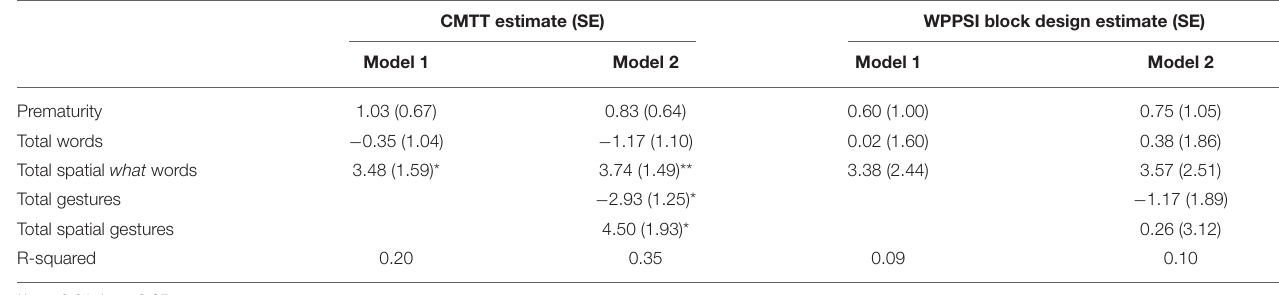
TABLE 5 | Hierarchical regressions predicting CMTT and WPPSI block design scores using prematurity, child words, subset of spatial what words, gestures, and spatial gestures.